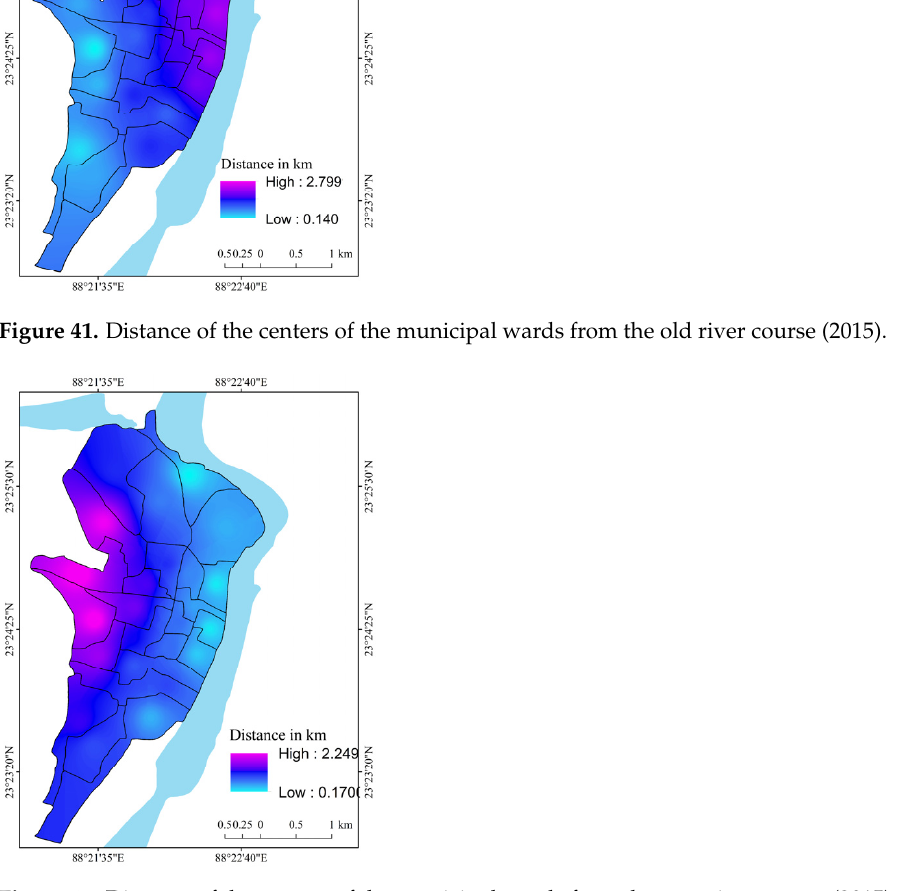
Figure 42. Distance of the centers of the municipal wards from the new river course (2015).